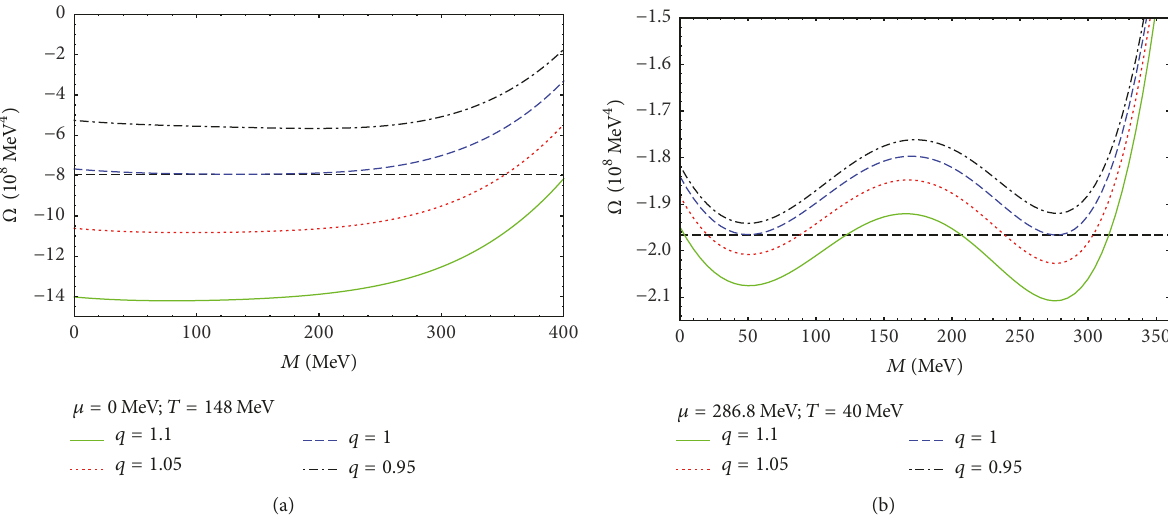
Figure 1: The thermodynamical potentials Ω (cf. (14) and (7)), with respect to the constituent (anti)quark mass 𝑀 . (a) 𝑇 = 148 MeV and 𝜇 = 0 . (b) 𝑇 = 40 MeV and 𝜇 = 286.8 MeV. We compare our results using the parameters near the phase boundaries. Both of them are analysed for 𝑞 = 1.1 , 𝑞 = 1.05 , and 𝑞 = 0.95 with the case of 𝑞 = 1 as comparisons.